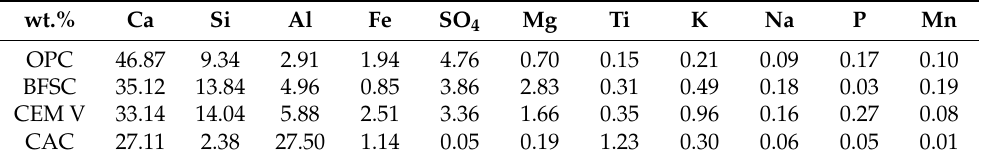
Table A1. Elementary chemical composition (in wt.%) of the different cements used in this study.